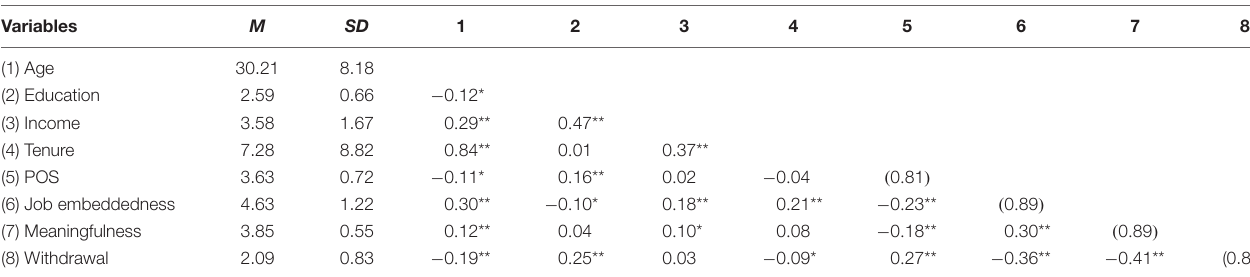
TABLE 1 | Means, standard deviations, and correlations among